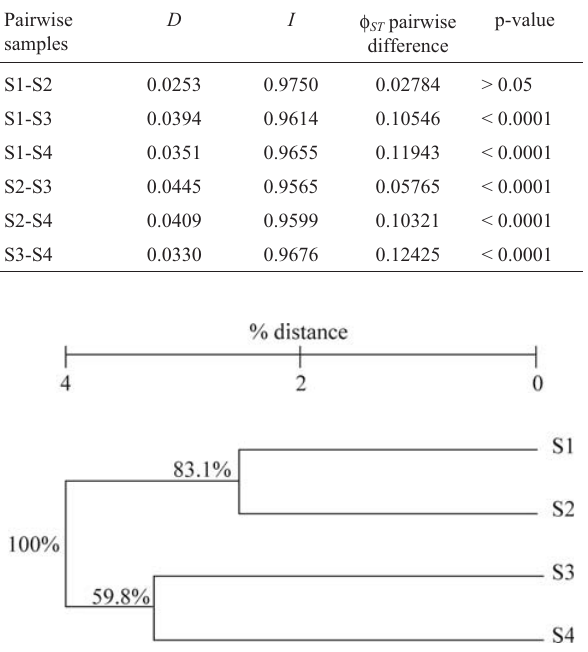
Figure4 -Dendrogramofgeneticdissimilarity(%),basedonNei’s(1978) genetic distance, for H. ancistroides populations from sites S1, S2, S3 and S4 on the Cambé stream. Numbers at the nodes represent bootstrap gener- ated by 1000